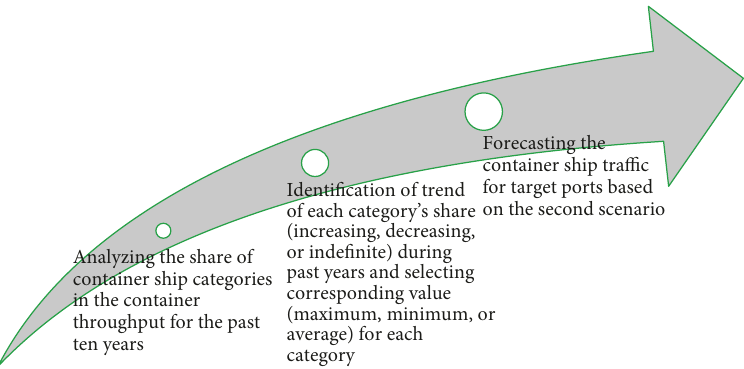
Figure 4: The procedure of forecasting container ship traffic in the second